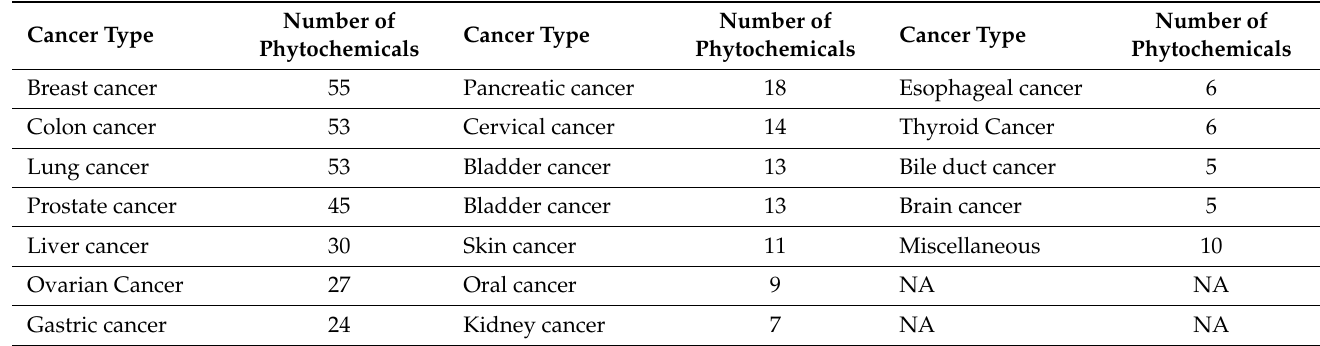
Table 3. Number of effective phytochemicals against different types of cancer.